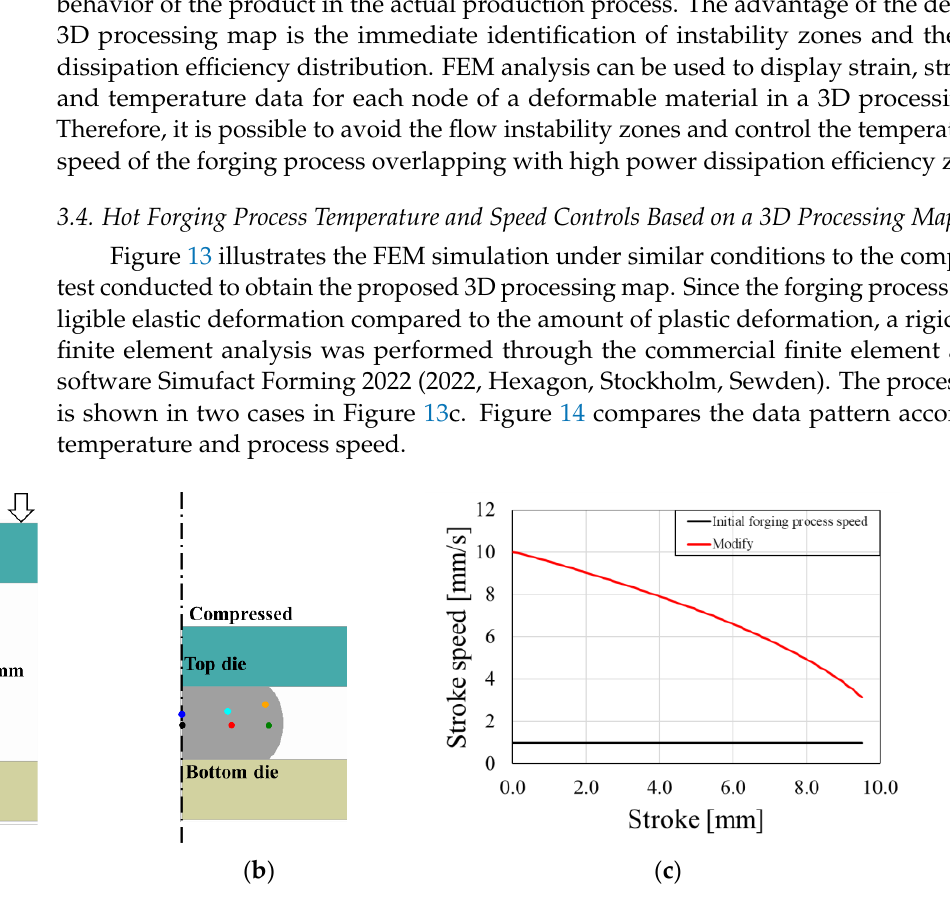
Figure 13. Schematic of axisymmetric cylinder forging simulation: ( a ) initial, ( b ) compressed, ( c ) process speed.